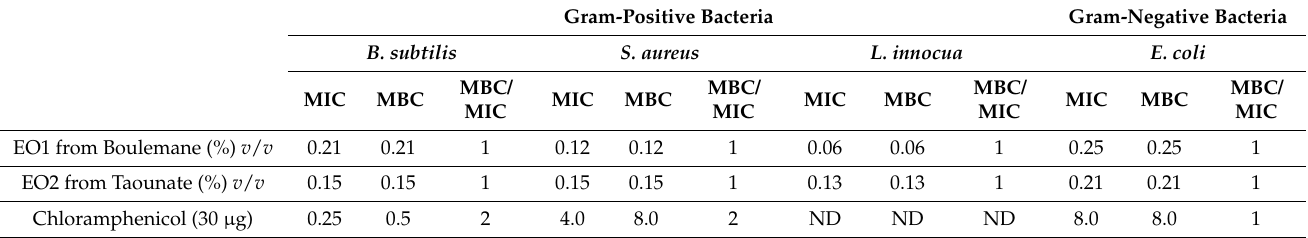
Table 6. MIC, MBC, and MBC/MIC values of O. compactum from Boulemane region (EO1 Boulemane) and O. compactum from Taounate region (EO2